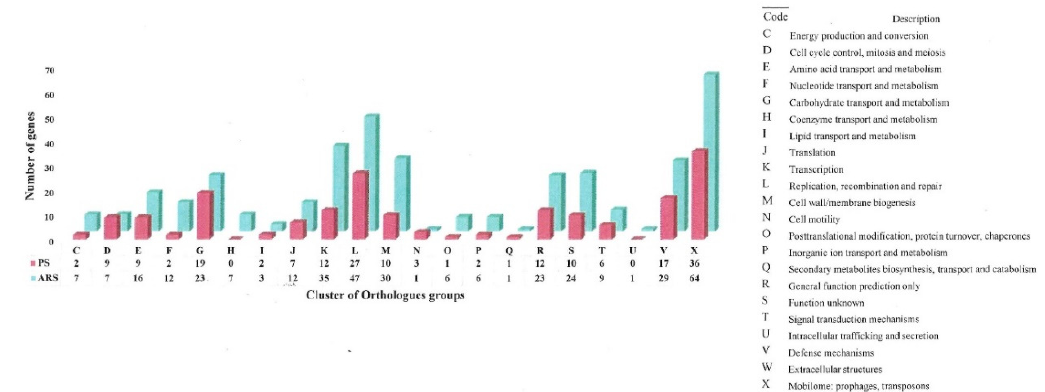
Figure 3. Distribution of unique genes in each Cluster of Orthologous Groups (COG) categories in clinical (PS; shown in pink) and non-clinical (ARS; shown in teal) Enterococcus cecorum isolates from chicken. The number of unique genes for each cluster is shown below the cluster code.